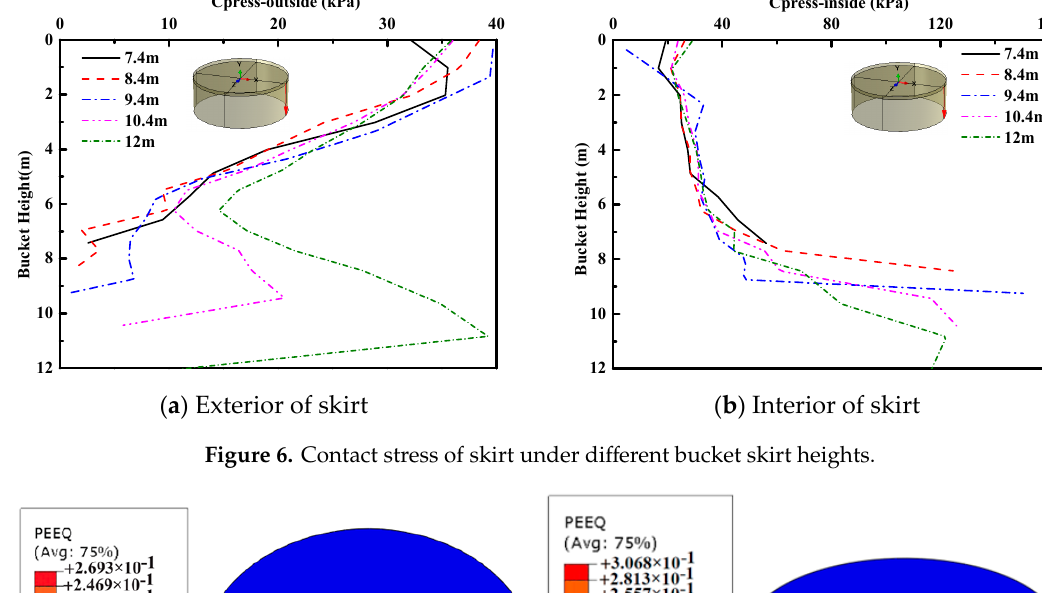
Energies 2019 , 12 , x FOR PEER REVIEW Figure 6. Contact stress of skirt under different bucket skirt heights. Figure 6. Contact stress of skirt under di ff erent bucket skirt heights.